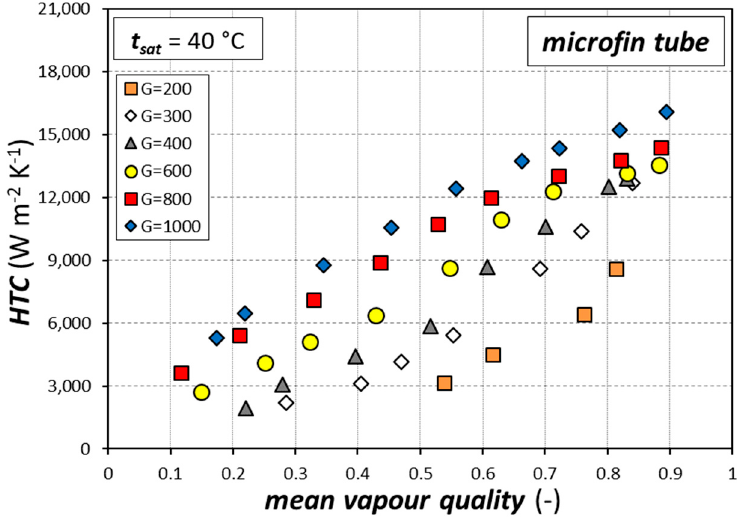
Figure 6. Heat transfer coefficient during condensation for the microfin tube vs. mean vapor quality at t sat = 40 °C. G expressed in [kg m − 2 s − 1 ].